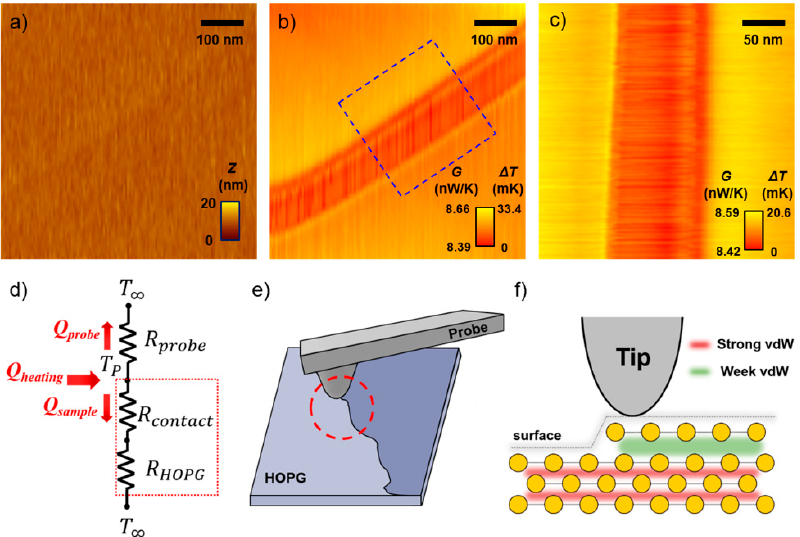
Figure 6. ( a ) Topography and ( b ) temperature images obtained simultaneously from a thermal scan of an HOPG sample (600 nm × 600 nm). ( c ) Enlarged image of the region marked by the blue rectangle in ( b ) (300 nm × 300 nm). ( d ) Thermal resistance network defined from the resistance to heat flow in the sample and SThM probe. R probe , R contact , and R HOPG are the thermal resistance of probe, interfacial thermal resistance, and thermal resistance of the HOPG, respectively. ( e ) Schematic for the measurement of the HOPG sample. Graphene sheet on the surface of the HOPG may be cracked or torn out between the sheets. ( f ) Schematic showing the difference in van der Waals (vdW) forces between graphene sheets.